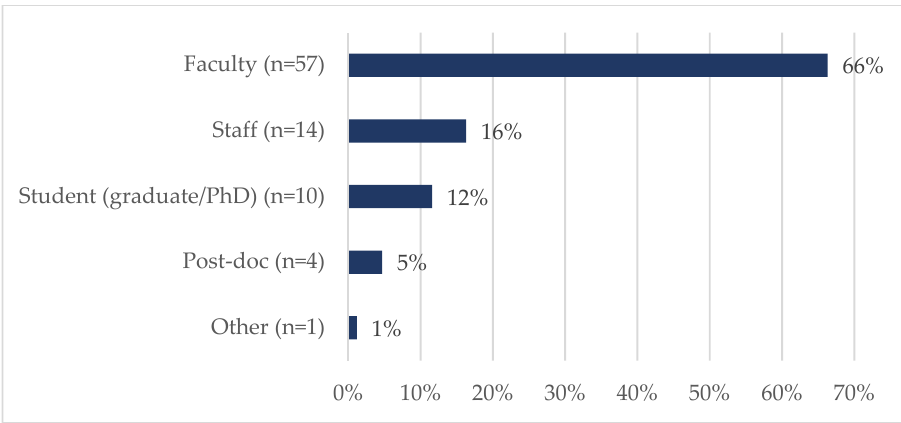
Figure 3. The professional role of TAG-SC users during Phase II: Pilot Year and Phase III: Year 1 of TAG-SC (N = 86).